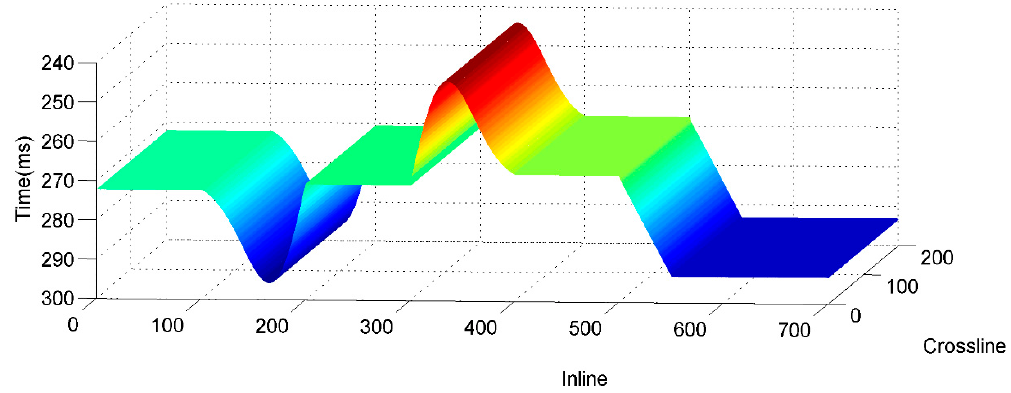
Figure 3. Geological structure model.